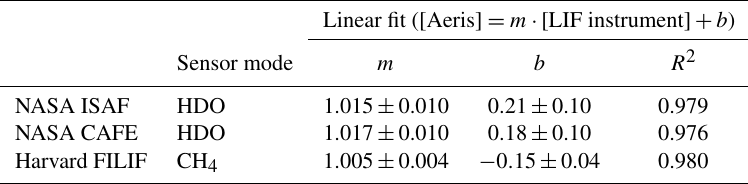
Figure 5. (a) Time series of the Aeris sensor (HAPP CH 4 fit) and Harvard FILIF during a multiday stepped intercomparison. All data are reported with an integration time of 30s. (b) Correlation plot between the Aeris sensor (HAPP CH 4 fit) and Harvard FILIF ( R 2 = 0 . 980). Table 2. Regression analyses for Aeris sensor vs. LIF instruments under laboratory conditions calculated with a 95% confidence